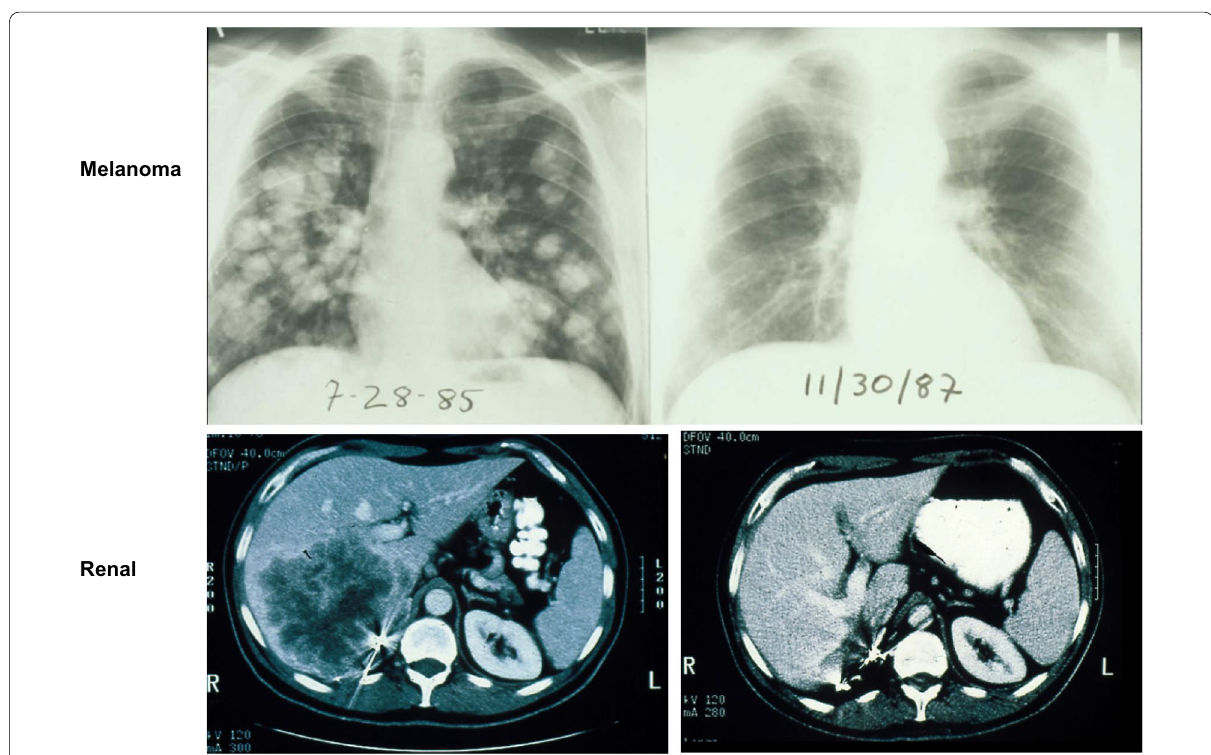
Fig. 2 Examples of the earliest complete responses to IL-2 administration that ultimately led to the first FDA approval of a cancer immunotherapy (upper panels, melanoma; lower panels, renal